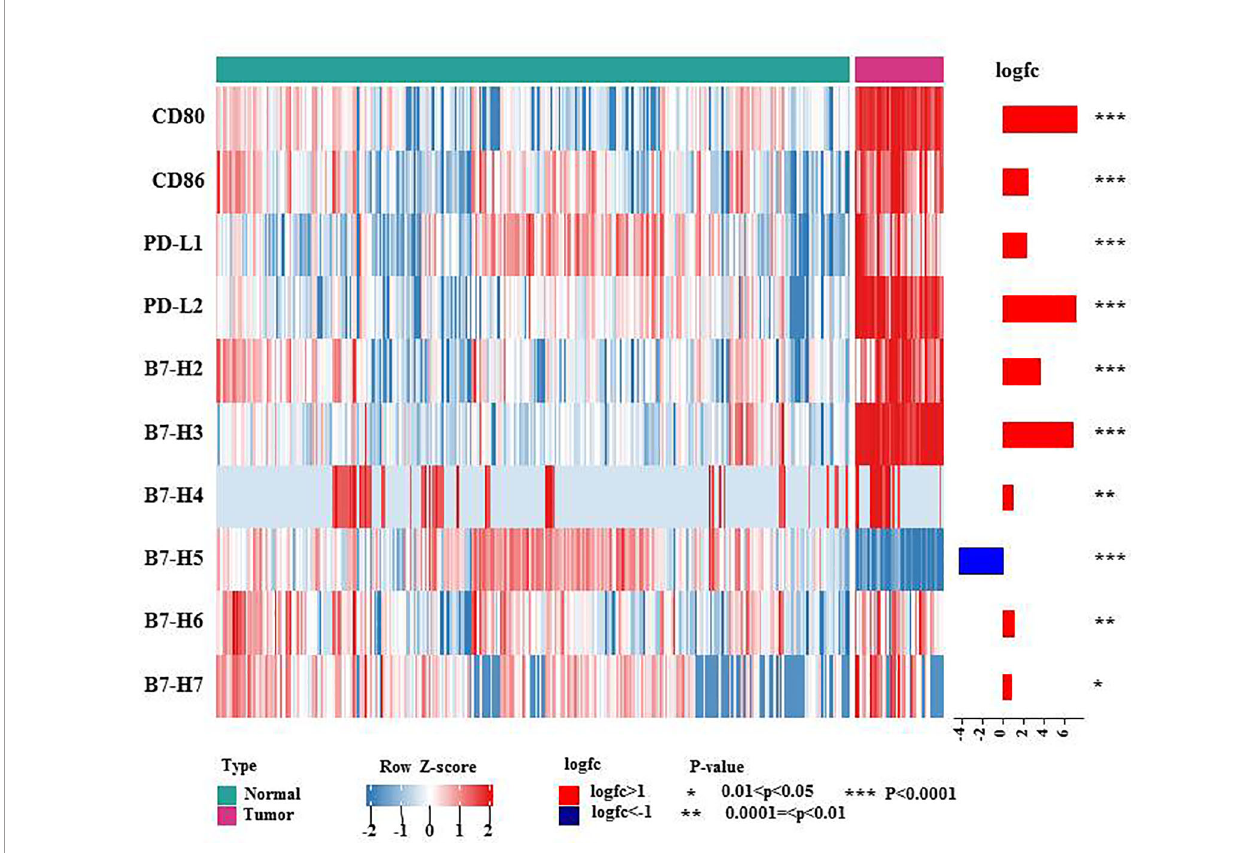
FIGURE 1 | mRNA expression levels of B7 family molecules in DLBCL. This heatmap shows the expression of the 10 genes of B7 family members in normal tissue and DLBCL: normal tissue from the whole blood cells of GTEx (n = 337), DLBCL from TCGA DLBCL (n= 47). The data were obtained from UCSC Xena and were log2 transformed and were analyzed by Mann-Whitney U test. * 0.01< P <0.05, ** 0.0001=< P <0.01, *** P